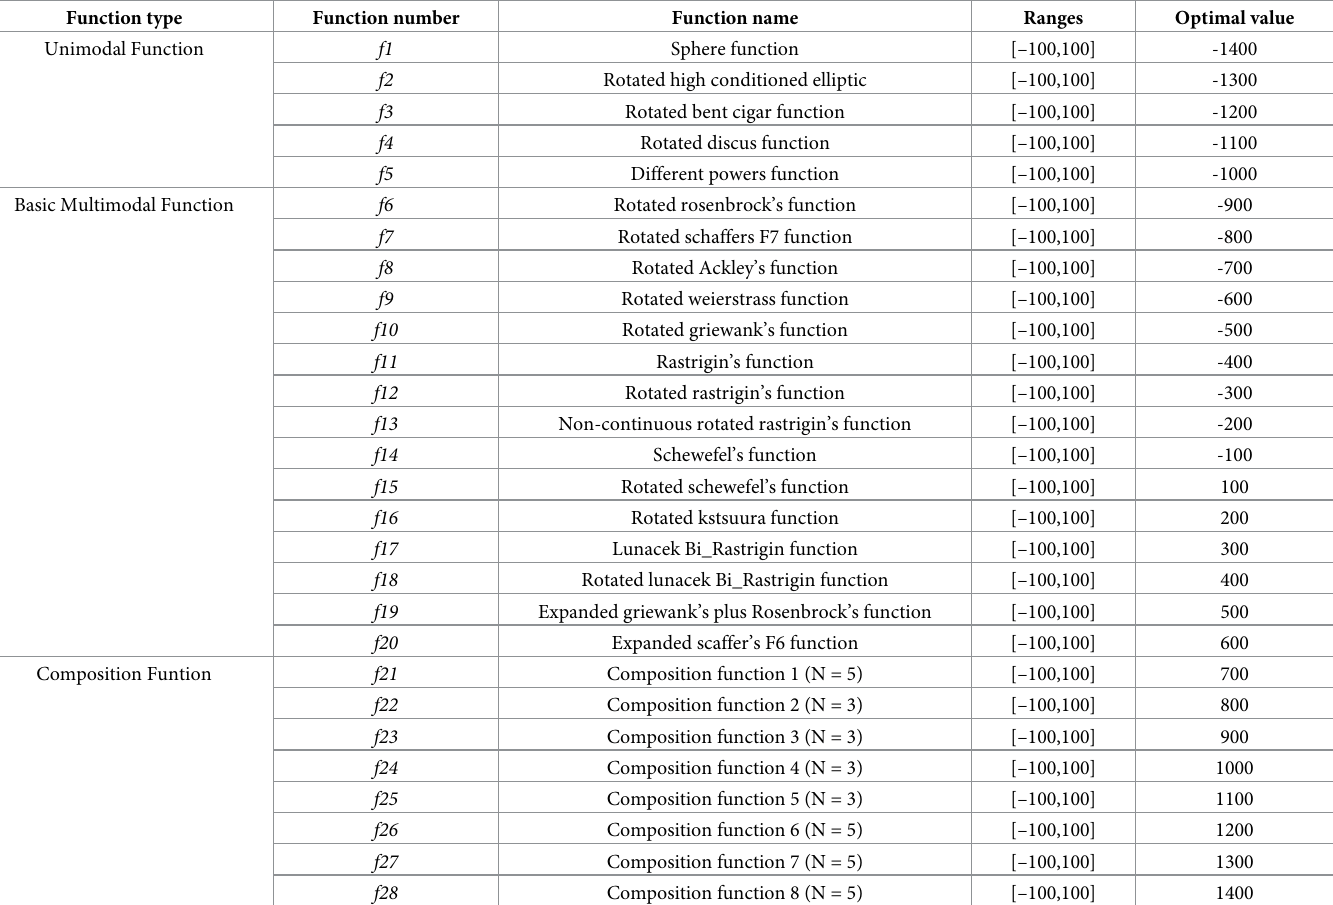
Table 1. Standard benchmark 28 test